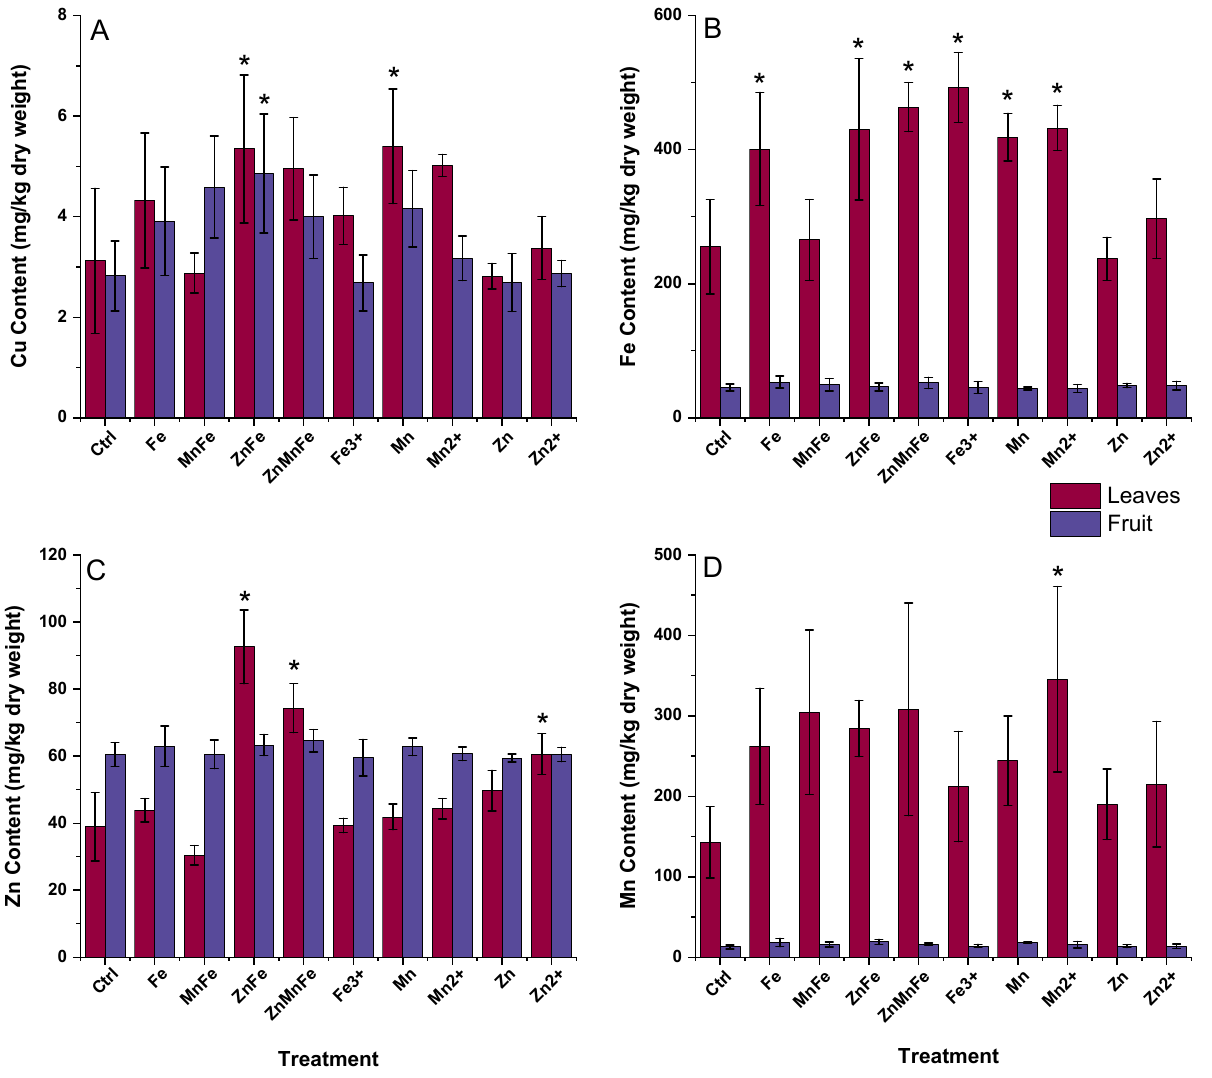
Figure 4. Effects of the Fe 3 O 4 (Fe), MnFe 2 O 4 (MnFe), ZnFe 2 O 4 (ZnFe), Zn 0.5 Mn 0.5 Fe 2 O 4 (ZnMnFe), Mn 3 O 4 (Mn), ZnO (Zn), or their ionic counterparts on the ( A ) Cu content, ( B ) Fe content, ( C ) Zn content, and ( D ) Mn content in the leaves and fruit; n = 4; * denotes statistical difference between control and treatments.